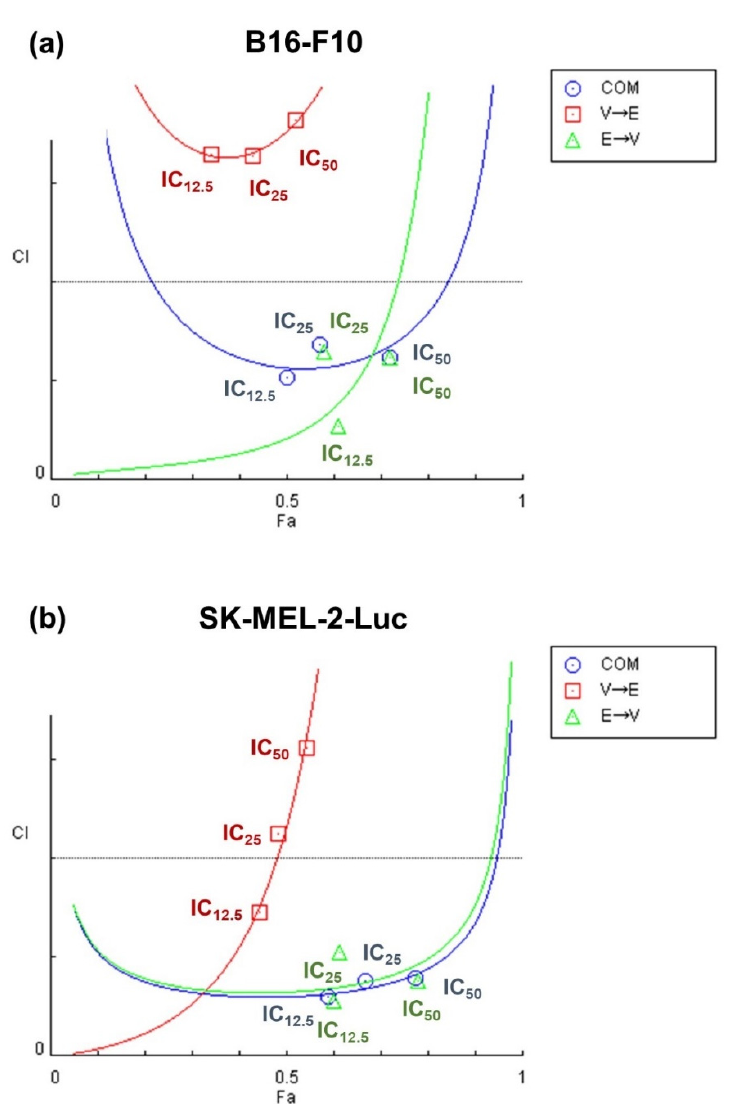
Figure 4. Fa-CI plot analysis of the synergistic and antagonistic effects of different VPA and ETO treatment schemes on inhibiting melanoma cells. The combination index (CI) values for simultaneous versus sequential combined treatments of VPA and ETO treatment schemes on ( a ) B16-F10 and ( b ) SK-MEL-2-Luc cells were calculated based on Chou and Talalay’s method via CompuSyn analysis software, 2005 Edition (ComboSyn, Paramus, NJ, USA). This analysis evaluates the effectiveness of combination treatment under the specified order of drug administration. In the Fa-CI plot, fractions of affected cells (Fa) represent the dead cells after drug treatments. Circle, square, and triangle symbols represent the CI values of each Fa under the specified treatment scheme with different orders of drug administration. The range of Fa is from 0 (no inhibition) to 1 (complete inhibition). The CI values are quantitative grading of synergism (CI < 1), additive (CI = 1), and antagonism (CI > 1). The IC 12.5 , IC 25, and IC 50 values are listed in Figure 2. IC 50 values are summarized in Table 1.